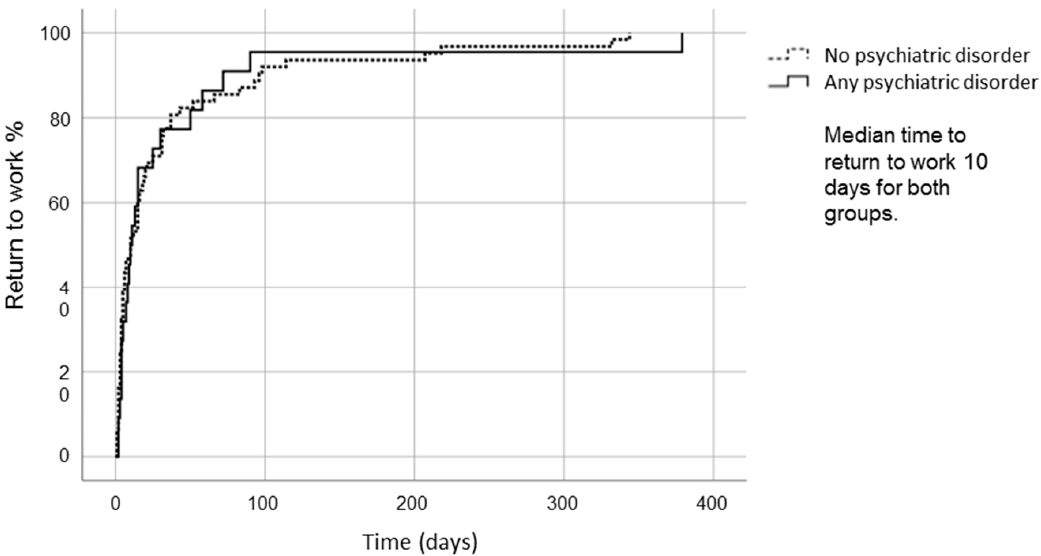
Figure 2. The effect of psychiatric disorder on return to work, as determined by Kaplan–Meier long rank rank analysis.